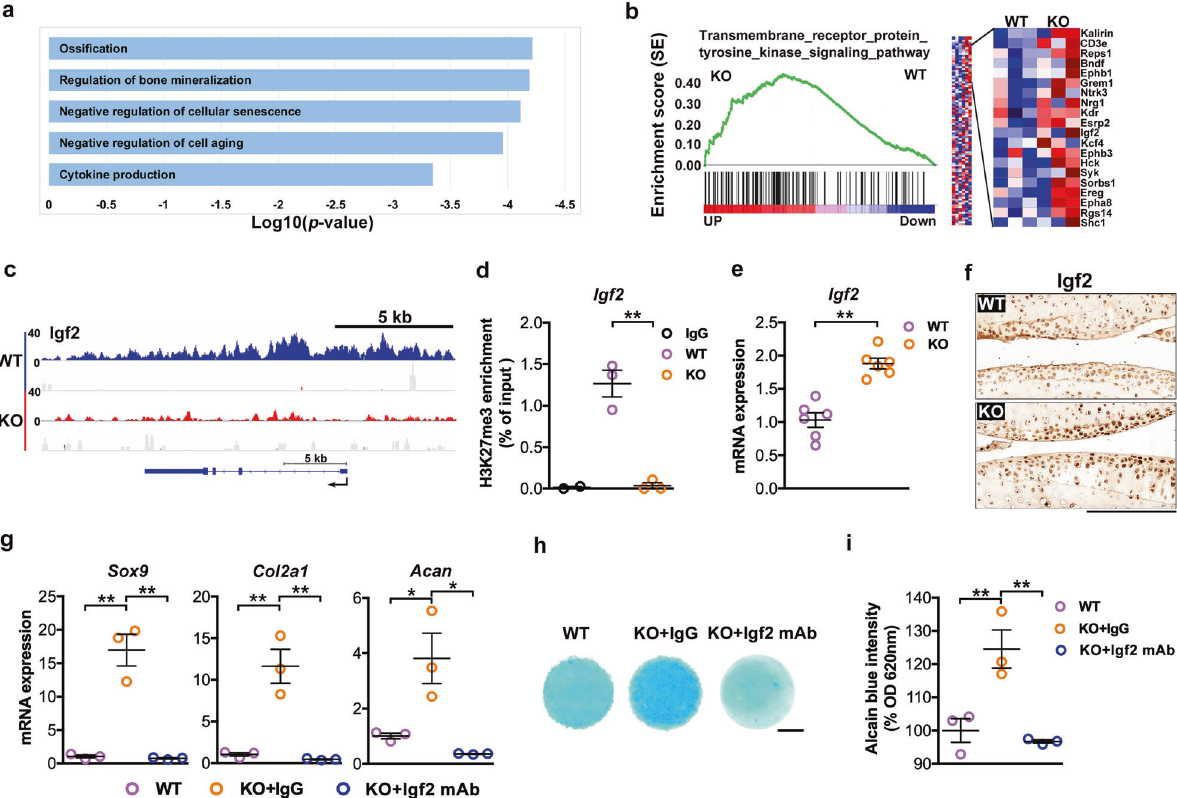
Fig. 6 UTX-dependence of H3K27me3-mediated Igf2 transcriptional repression. Selected H3K27me3-enriched GO terms in UtxKO chondrocytes ( a ). Gene set enrichment analysis of H3K27me3 marks revealed signi fi cant enhancement a speci fi c pathway in UtxKO cells. Igf2 was selected as differentially regulated and earlier reported H3K27me3-mediated candidates controlling chondrocyte differentiation (enlarged section) ( b ). Gene track illustrating limited H3K27me3 chromatin occupation at regulator loci and promoter regions of Igf2 gene in UtxKO chondrocytes (red) as compared to WT cells (blue) ( c ). This con fi rmed highly signi fi cant differences in the enrichment of H3K27me3 by ChIP-PCR assay ( d ). Increased transcription of Igf2 in UtxKO cells ( e ) and evident Igf2 immunostaining (scale bar, 10 μ m) in UtxKO cartilage ( f ). Antibody-mediated blockade of Igf2 suppressed Sox9, Col2a1, and Acan expression ( g ), as well as glycosaminoglycan production ( h , i scale bar, 500 μ m), in UtxKO chondrocytes. Cells were incubated in medium with Igf2 antibody or IgG. RT-PCR was conducted upon antibody treatment for 24 h. Micromass for Alcian blue staining was incubated for 7 days. Cell cultures were harvested from three mice and experiments were repeated three times. Data are expressed as mean ± standard errors. * P < 0.05; ** P <